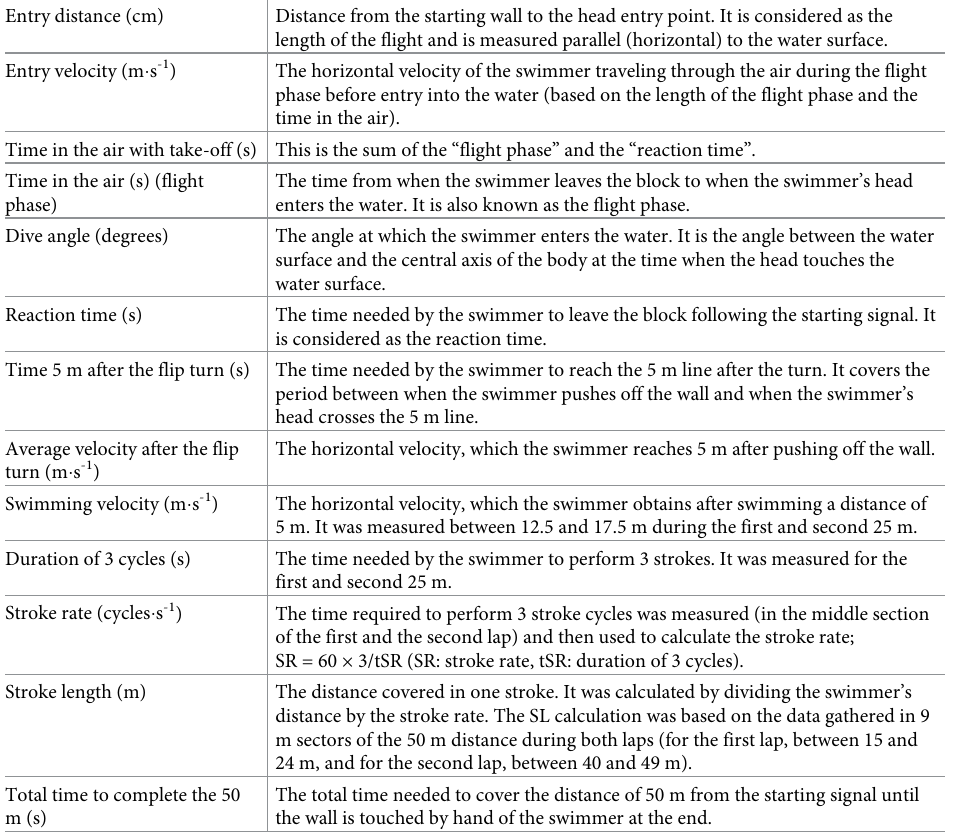
Table 3. Detailed description of the parameters measured by using the Kinovea software while swimming 50 m front